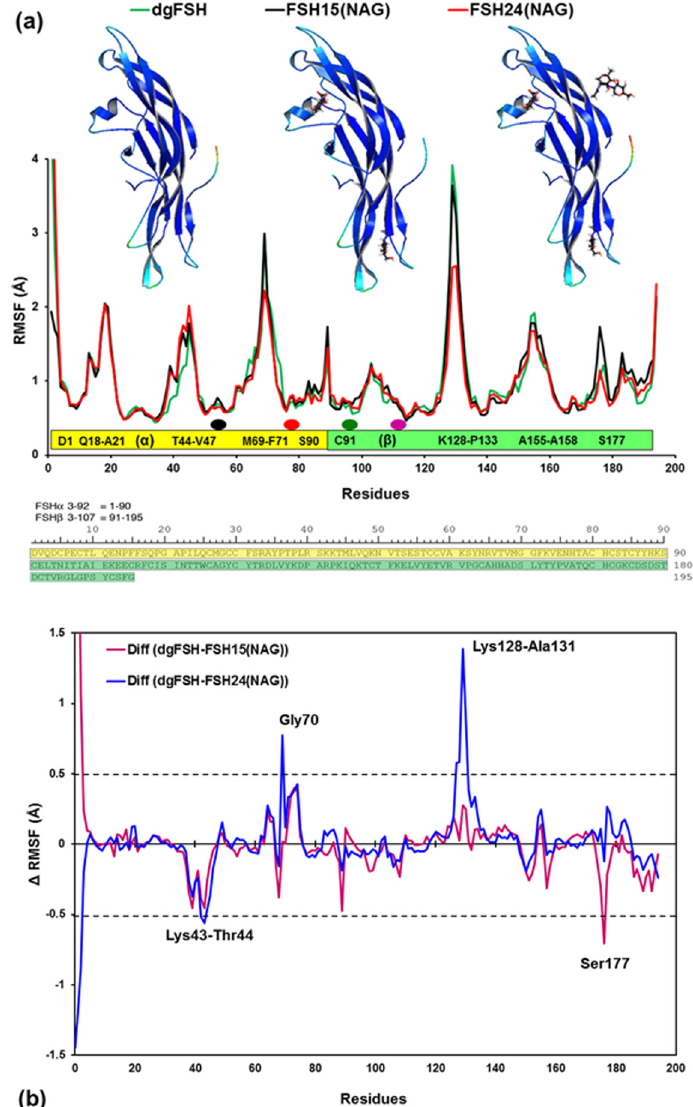
Fig 6. (a) Plot showing RMSF values of C α atoms from MD simulations of dgFSH (in green), FSH 15 (NAG) (in black), and FSH 24 (NAG) (in red). Residues associated with the RMSF, showing each subunit as a bar ( α - subunit: yellow bar and β -subunit: green bar) and single-letter code sequences with residue numbers for the regions where RMSF changes reasonably. Oval dots over the bar are shown for the potential N-glycosylation sites (Black & Orange dots for Asn52 & Asn78 on FSH α and Green & Purple dots for Asn7 & Asn24 on FSH β ). Residue sequences with reasonable RMSF changes of at least > 1.0 Å are labeled inside the bars in each subunit. Ribbon models: Color-coded mapping of the averaged protein flexibility profiles (RMSF values) from MD simulations of the dgFSH, FSH 15 (NAG) and FSH 24 (NAG) (from left to right). The color-coded sliding scheme corresponds to the following ranges of protein flexibility values: red (highly flexible with +5.00 Å values), brown (+4.00 Å values), yellow (+3.00 Å ), green (+2.00 Å ), cyan (+1.00 Å ) and blue (the least flexible). The amino acid sequences for FSH α residues 3 – 92 (yellow), and FSH β 3 – 107 (green) are shown in the lower panel of the figure. (b) Difference of RMSF values for FSH 15 (TAG) and FSH 24 (TAG) from dgFSH. The specific residues with absolute difference larger than 0.50 Å (dashed lines) are